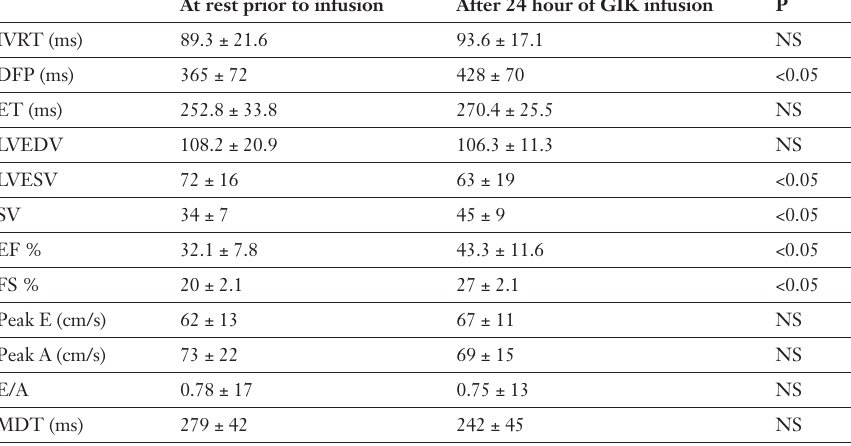
Echocardiography parameters at rest before and after 24 hour of GIK- infusion (values are mean ±